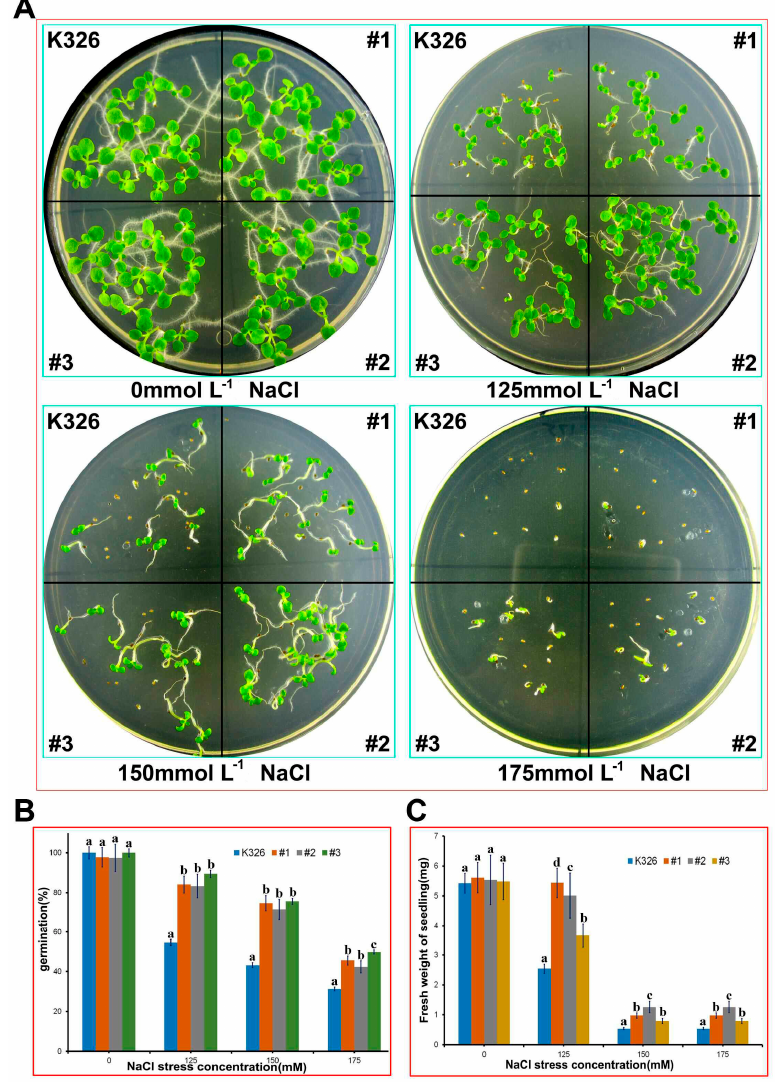
Figure 7. Resistance analysis of PtMAPKK4 transgenic tobacco and WT in 0, 125, 150, and 175 mmol·L − 1 NaCl culture at germination stage ( A ); Germination rate ( B ) and fresh weight ( C ) were measured separately. Letters a, b, c and d represent a significant difference of the means at p < 0.05. Seeds of #1, #2, and #3 transgenic homozygous lines and WT were germinated and grown on 1/2 MS medium for 9 days. Consistently grown seedlings were selected for transplant onto 1/2 MS medium containing 0 (control), 125, 150, and 175 mM NaCl and were vertically placed on the dish for 15 days. Growth of seedlings in all salt treatment groups was significantly inhibited by salt. However, transgenic lines showed better salt tolerance than WT (Figure 8A). Root length and fresh weight of transgenic lines were higher than those of WT (Figure 8B,C). MDA content serves as an indicator of plant cell oxidative damage; NaCl stress treatment increases MDA content in plants. This study detected MDA content of WT and overexpressed lines under different treatments (Figure 8D). MDA content was low and not significantly different between WT and overexpressed lines in 0 mM NaCl control. However, MDA content positively correlated with salt concentration in treatment groups and was significantly higher in WT than in overexpressed lines. Overexpression of PtMAPKK4 alleviated salt stress-initiated oxidative toxicity of plant cells.